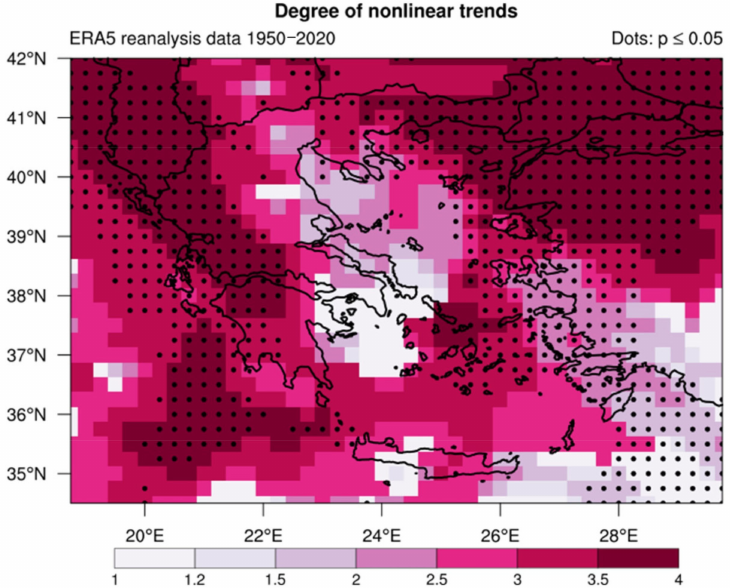
Figure 11. Spatial distribution of GAM-derived effective degrees of freedom. Values close to 1 indicate linear trends. Higher values (>2) indicate nonlinear trends. Dots represent 95% confidence